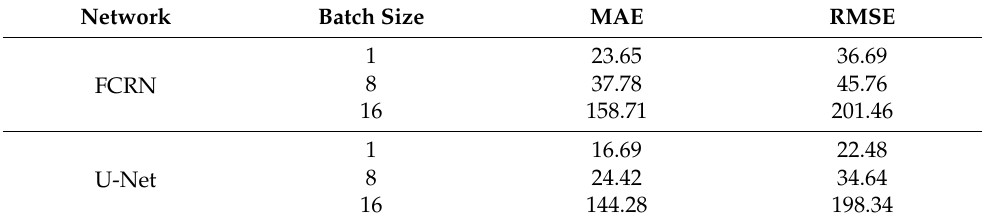
Table 1. FCRN and U-Net